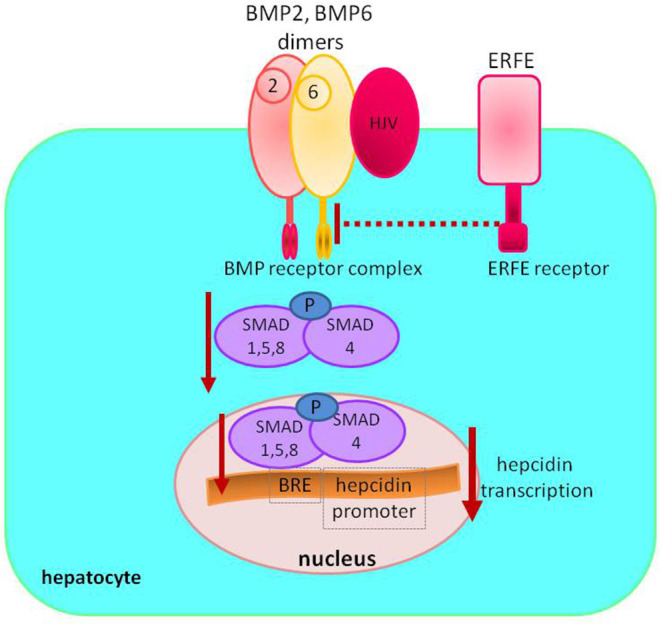
Regulation of hepcidin synthesis by erythroferrone. Increased circulating levels of ERFE sequestrate BMP receptor ligands to decrease SMAD1/5/8 phosphorylation; lower levels of phosphorylated SMAD1/5/8 result in less SMAD1/5/8–SMAD4 complex formation, diminishing its nuclear concentration and decreasing hepcidin transcription. ERFE, erythroferrone; BMP, bone morphogenetic protein; SMAD, suppressor of mothers against decapentaplegic proteins; HJV, hemojuvelin; BRE, BMP-responsive elements in the hepcidin promoter; P, phosphate.